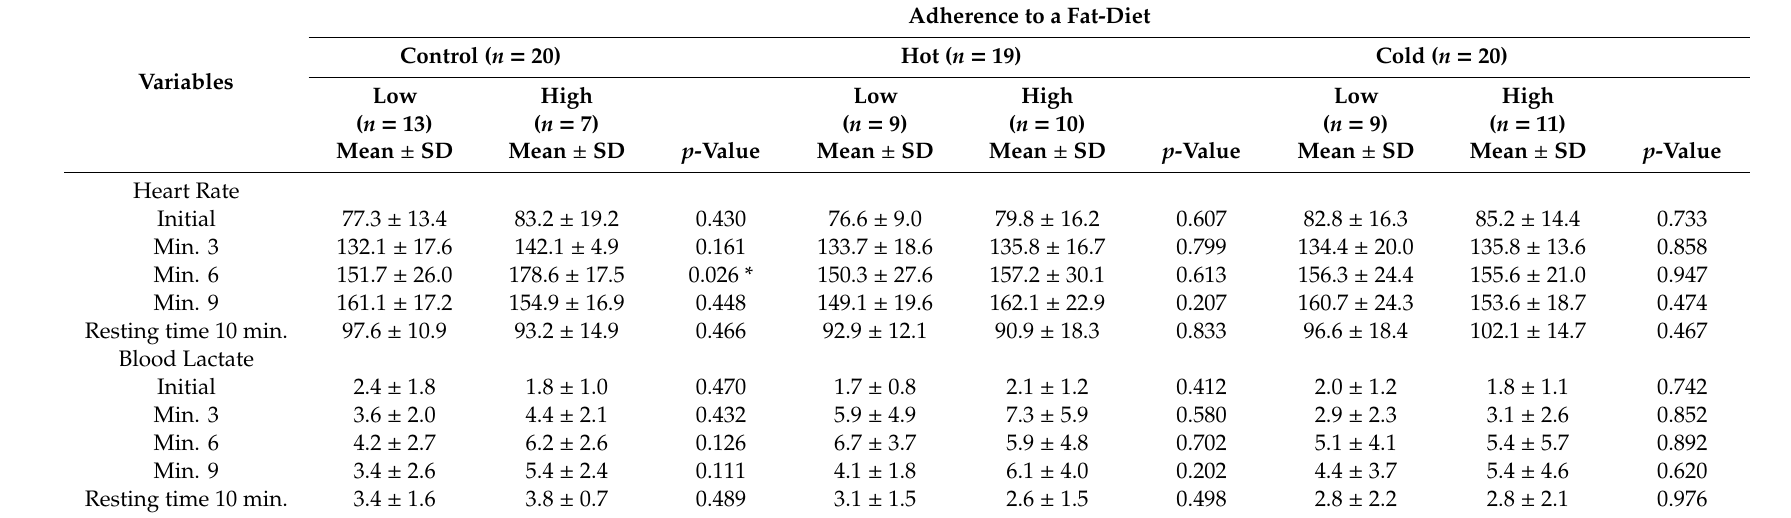
* Statistically significant di ff erences. SD, standard